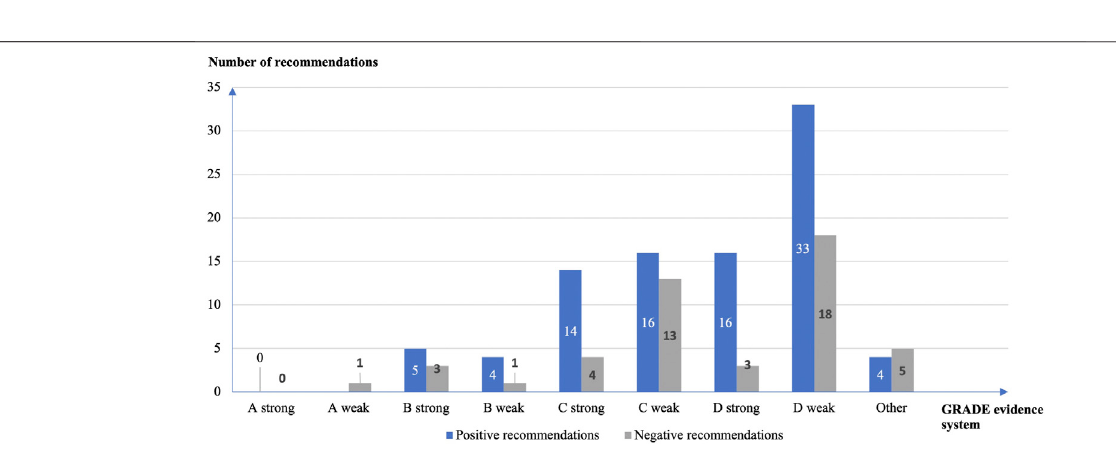
Frontiers in Pharmacology |